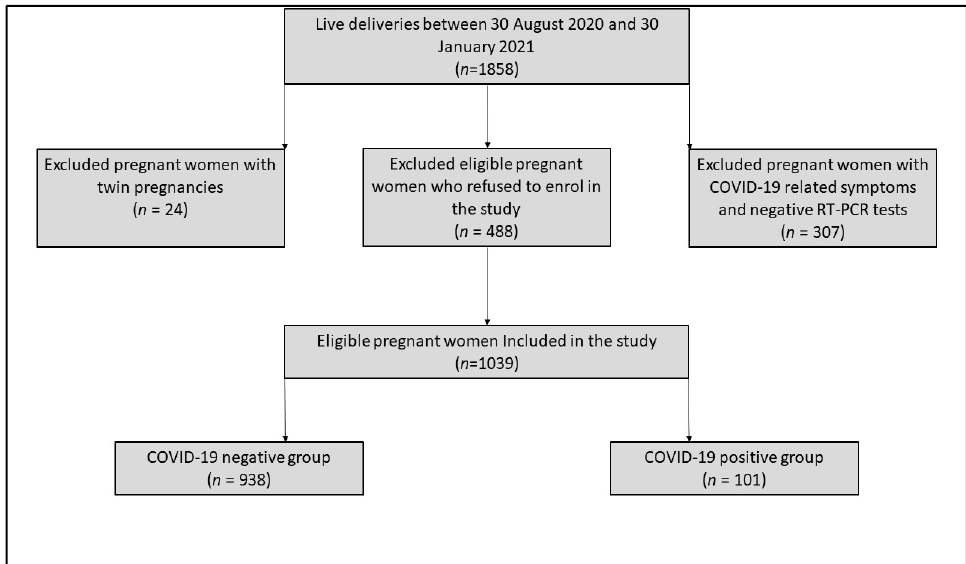
Figure 1. Flow chart of the study participants.